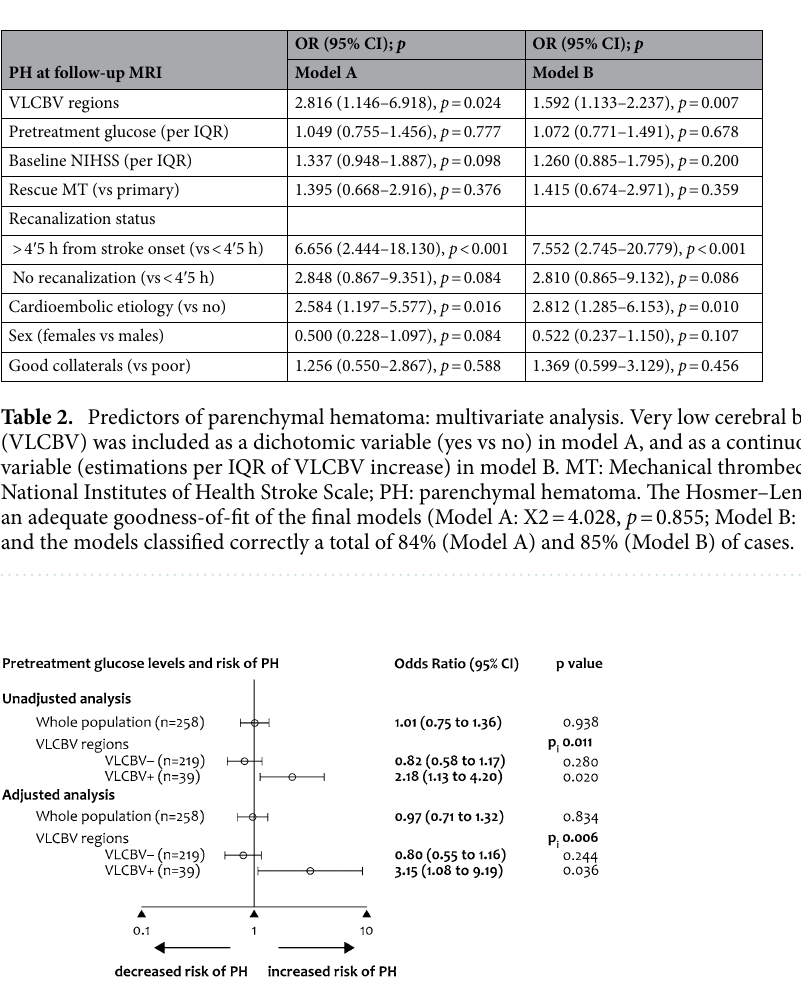
Figure 1. Binary regression models for predicting the occurrence of parenchymal hematoma (PH) in follow-up MRI. Pi is the p value for the interaction between pretreatment glucose levels and the presence of very low cerebral blood volume (VLCBV) regions for the prediction of PH. Data are OR and 95% CI per IQR increase in glucose levels obtained by unadjusted models and in models adjusted for pretreatment NIHSS, recanalization and cardioembolic stroke etiology (see Supplemental Table 3 for full